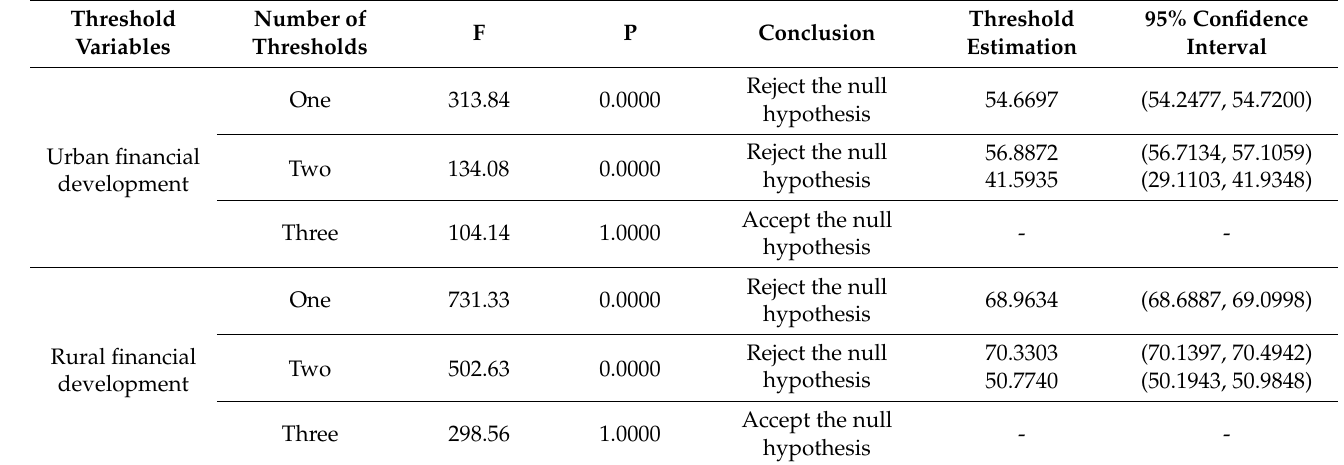
Table 8. Threshold estimation of the grouped sample of urban and rural areas.